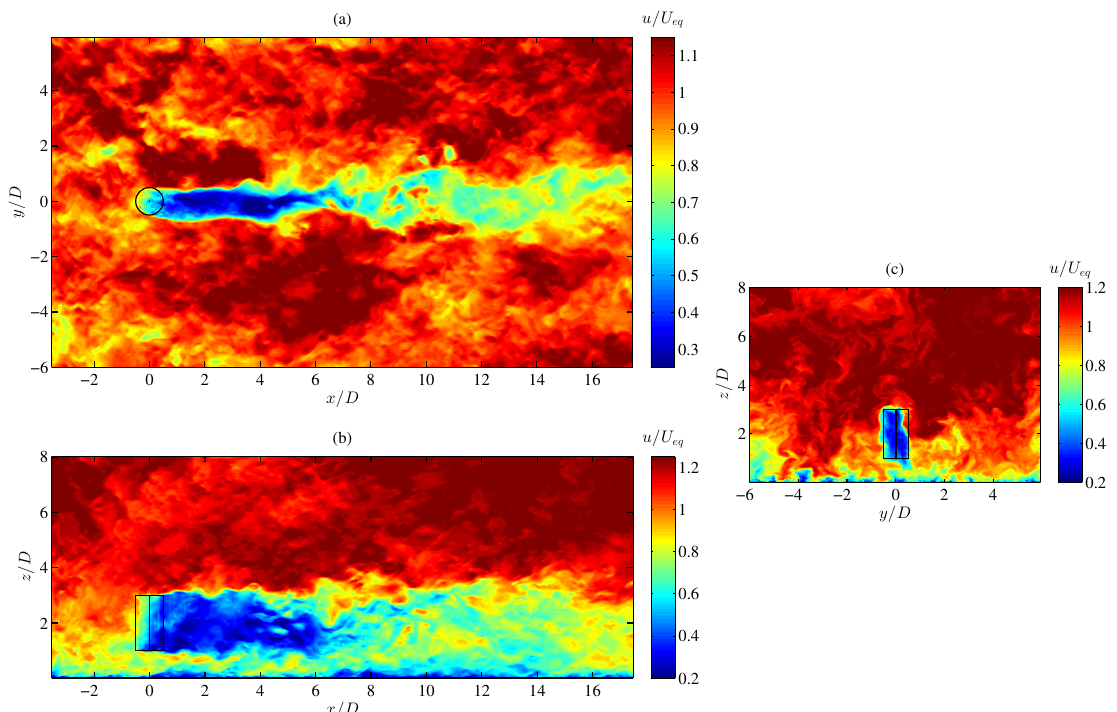
Figure 5. Contour plots of the instantaneous normalized streamwise velocity ( u / U eq ) in three different planes: ( a ) the x - y plane at the equator height of the turbine; ( b ) the x - z plane going through the center of the turbine; ( c ) the y - z plane which is 2D downstream of the center of the